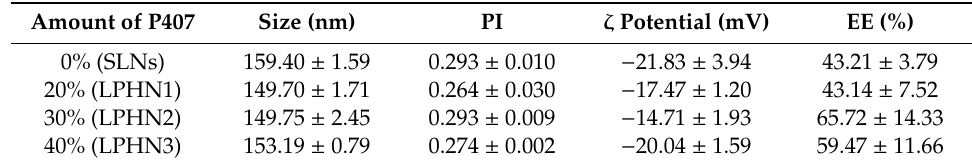
Table 1. Characterization of enoxaparin-loaded lipid-polymer hybrid nanoparticles at 3 di ff erent ratios of poloxamer 407 ( n =